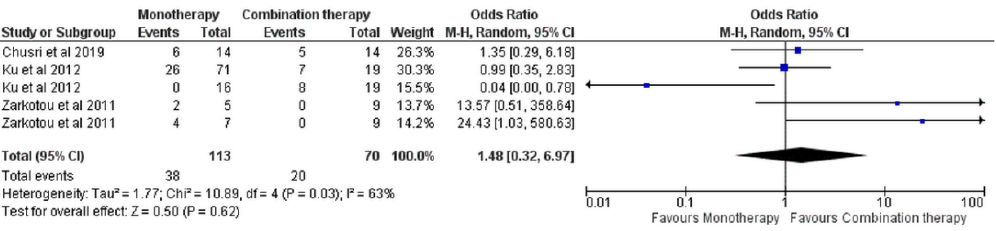
Figure 7. Thirty-day mortality of monotherapy versus combination monotherapy [7,13–15,18,24]. For the in-hospital mortality, a similar trend of no difference between the monother- apies and the combination was observed, based on three studies [13,15,16] (OR = 1.48, 95% CI [0.32, 6.97], p = 0.62), Figure 8, with significant heterogeneity (I 2 = 63%, p = 0.03). Via sensitivity analysis and the exclusion of the subgroup of Ku et al. [15], with OR = 0.04, 95% CI [0.00, 0.78], the outcome did not change (OR = 1.80, 95% CI [0.85, 3.84], p = 0.13), Figure S1.10.